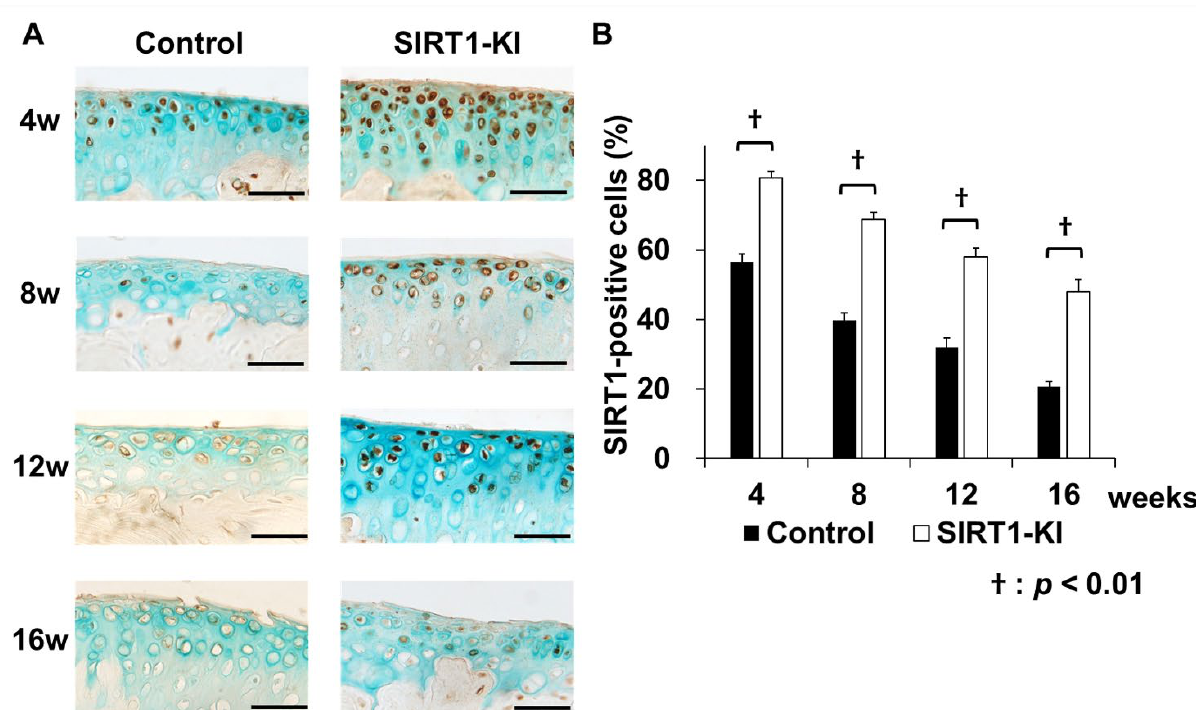
Figure 3. ( A ) Immunohistochemistry of SIRT1 in the medial tibial plateau at 4, 8, 12, and 16 weeks postsurgery. Scale bars = 50 μm. ( B ) The percentage of SIRT1-positive chondrocytes. Three micrographs of the medial tibial plateau were taken under ×40 magnification. The percentage was determined as the positive chondrocytes/total number of chondrocytes at ×100 magnification ( n = 5 mice/group for each time point; † p < 0.01).